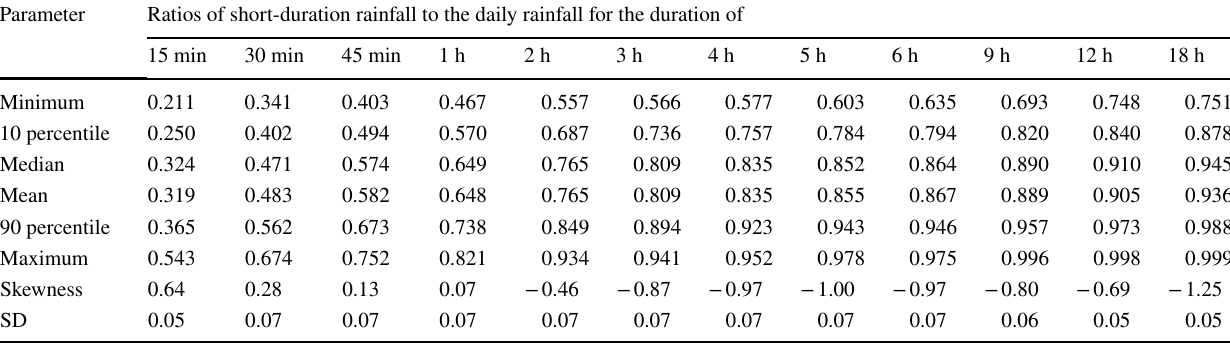
Table 2 Statistical summary of the short-duration rainfall ratios to the daily rainfall Parameter Ratios of short-duration rainfall to the daily rainfall for the duration of